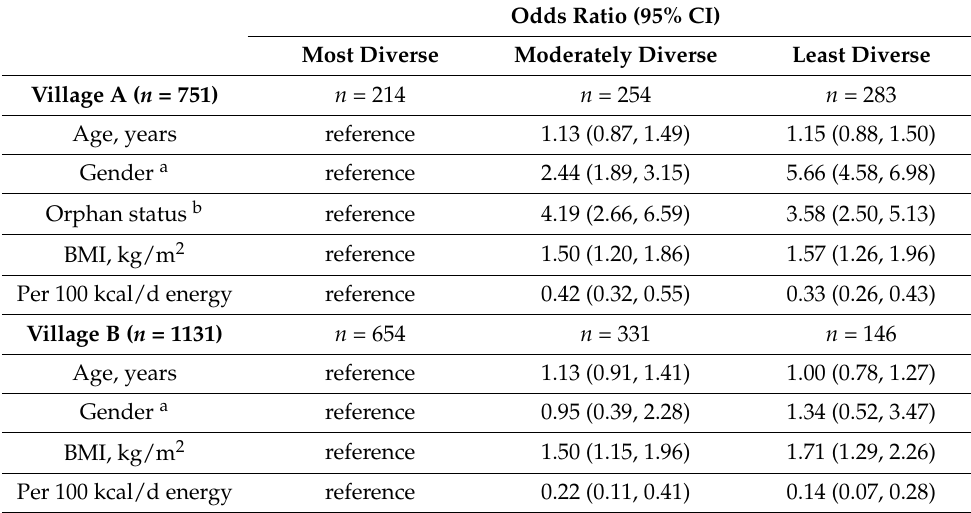
Table 3. Odds Ratios and 95% Confidence Intervals (CI) between children’s characteristics and dietary patterns in two villages in western